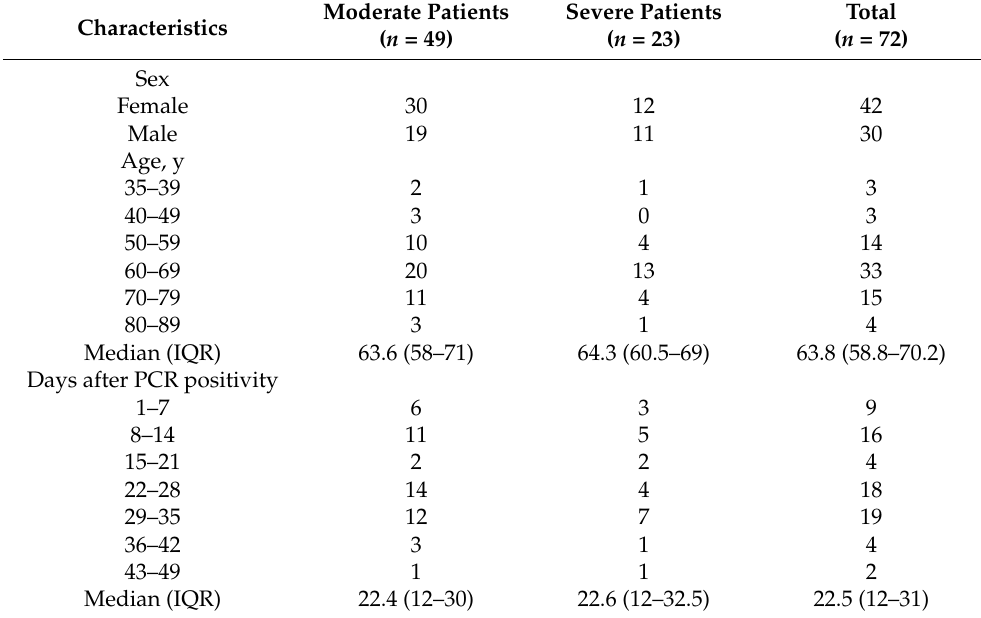
Table 2. Baseline characteristics of patients infected with